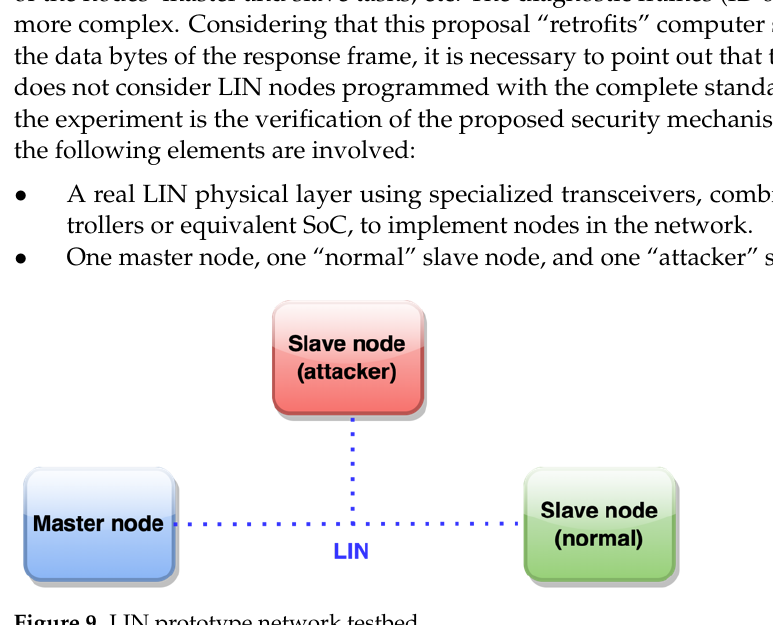
Figure 9. LIN prototype network testbed.